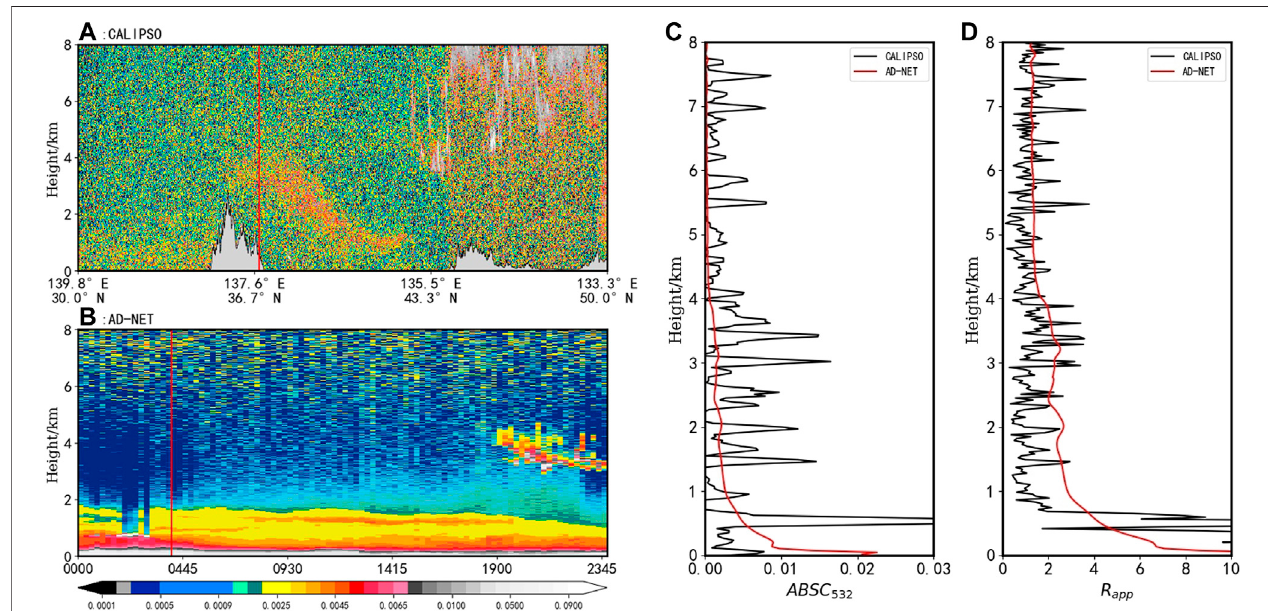
FIGURE 7 | The attenuated backscatter coef fi cient pro fi le from CALIOP (A) and the AD-NET (B) , and the comparison of the ABSC 532 value (C) and the R app value (D) from CALIOP and the AD-NET ground-based lidar innorthern Japan onMarch 14th, 2018UTC (the solid black line in (A) and (B) shows the nearest position against the ground-based station and the closest time to the CALIPSO transit time,